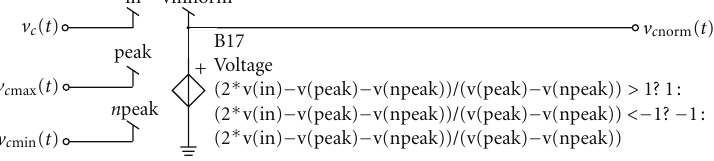
Figure 4: O ff set/amplitude corrector sub-model.